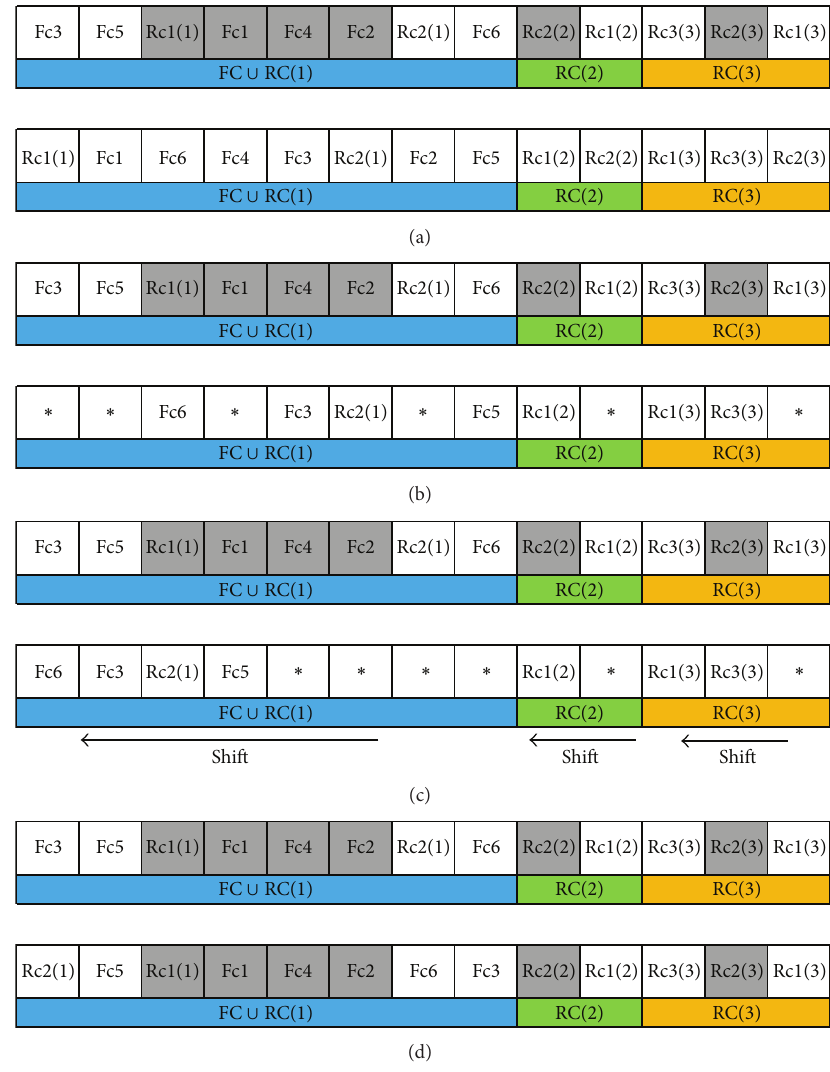
Figure 7: Ordered crossover